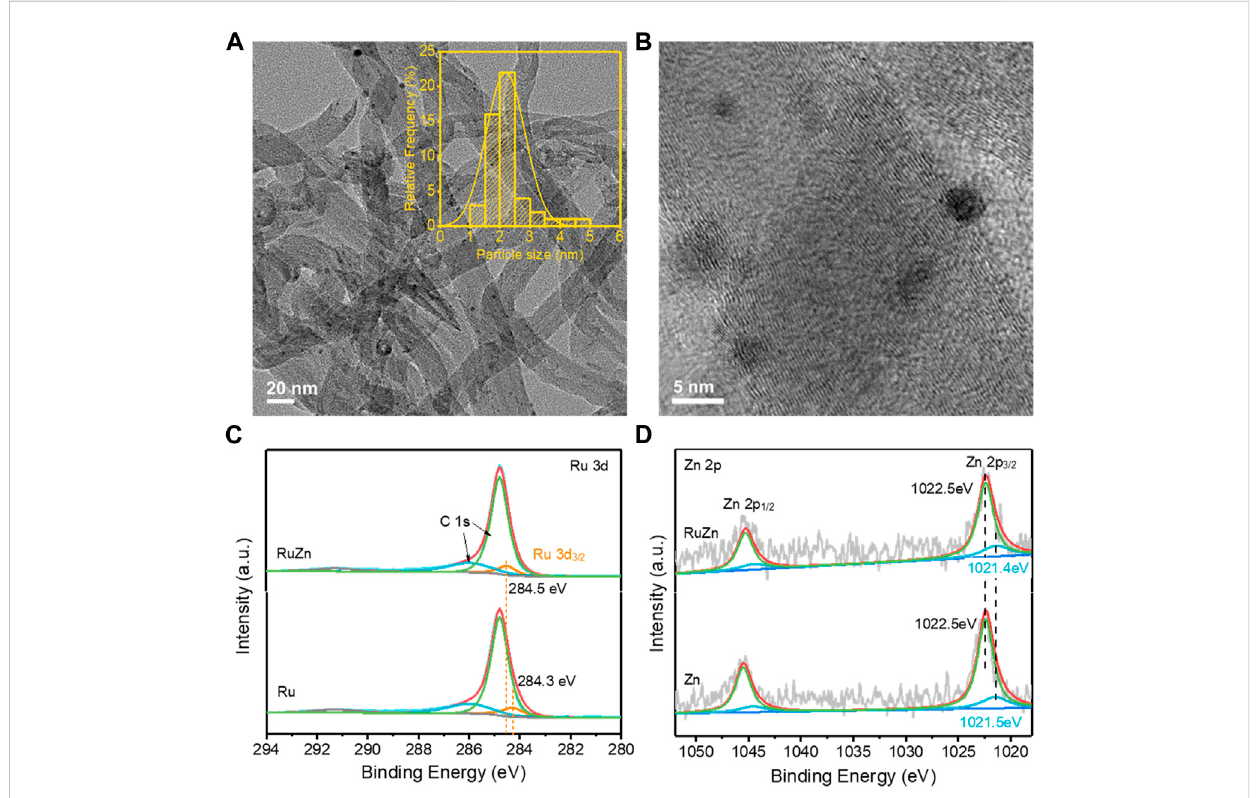
FIGURE 4 The structural and electronic properties of the 4 wt% Ru-Zn/MWCNTs catalysts and the counterparts. (A) TEM images, inset: particle size distribution; (B) highresolutionTEMimages; (C) XPSspectrafortheRu3 daysregionsofthe4 wt%Ru-Zn/MWCNTsand4 wt%Ru/MWCNTssamples; (D) XPS spectra for the Zn 2p regions of the 4 wt% Ru-Zn/MWCNTs and 4 wt% Zn/MWCNTs